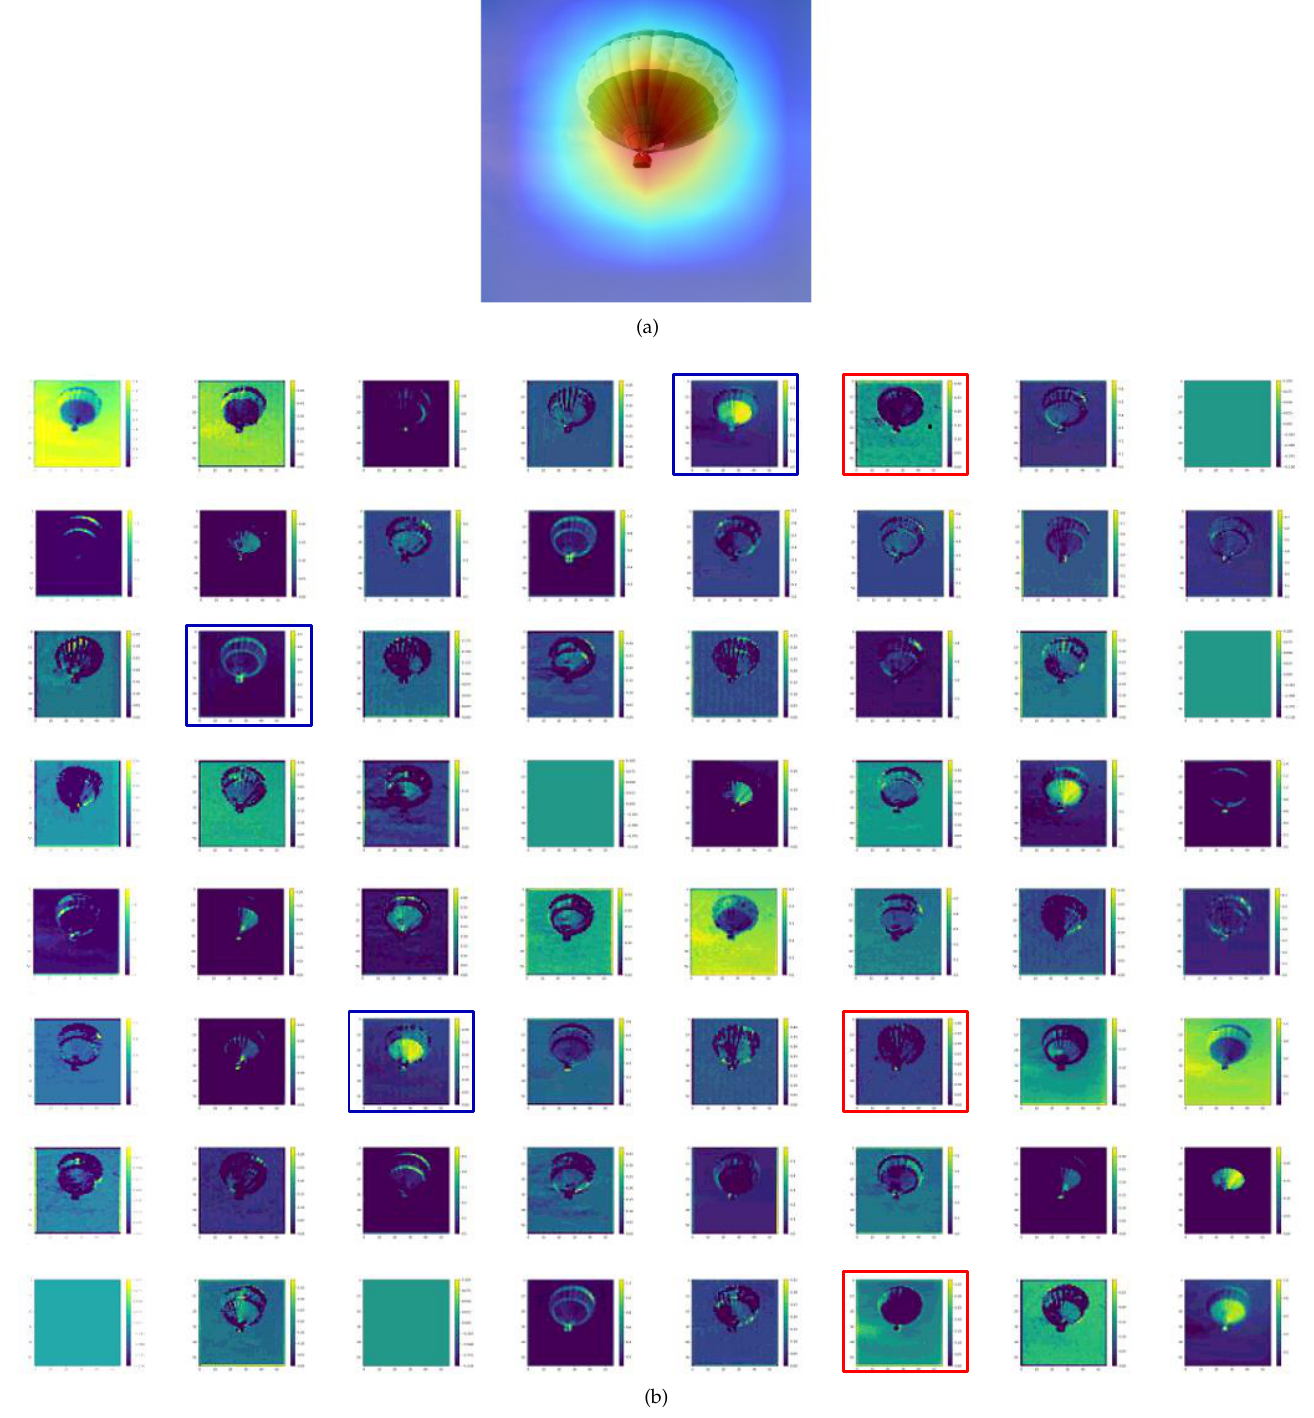
Figure 2. An image and its feature maps on the fifth convolution layer of ResNet50. ( a ) Input image with attention; ( b ) Feature maps on one